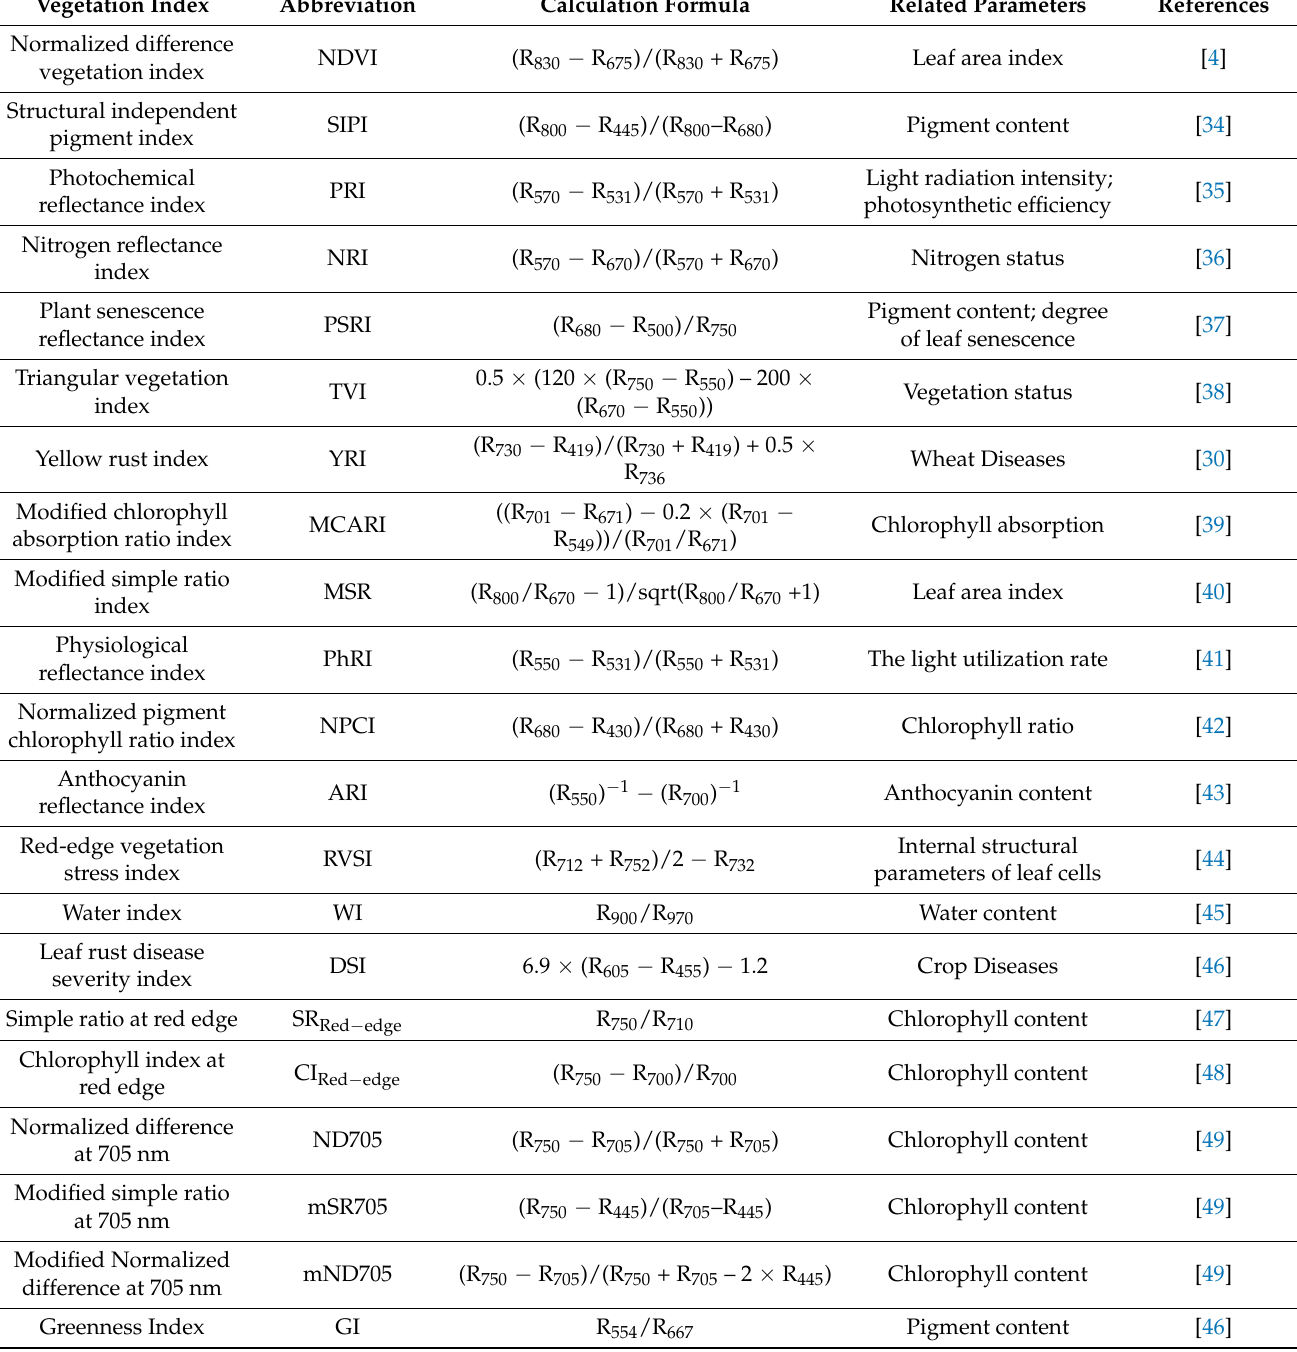
Table 3. List of 21 selected spectral vegetation